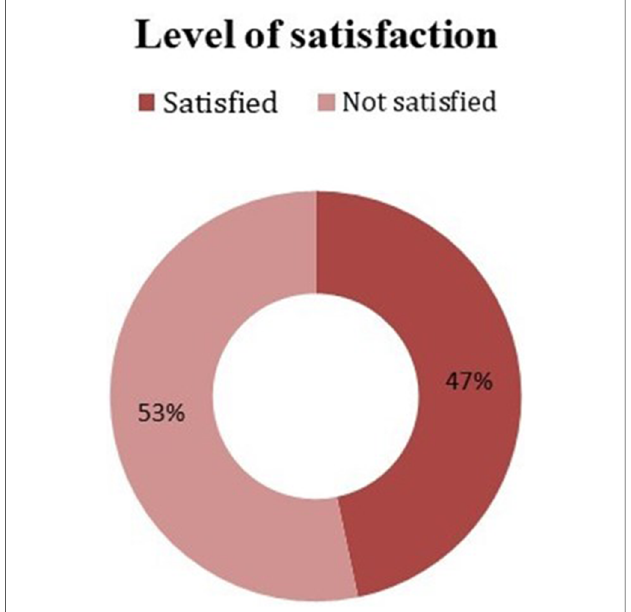
FIGURE 1 Satisfaction levels of pregnant women with focused ANC service at public health facilities of the West Shewa Zone, Central Ethiopia, 2021.